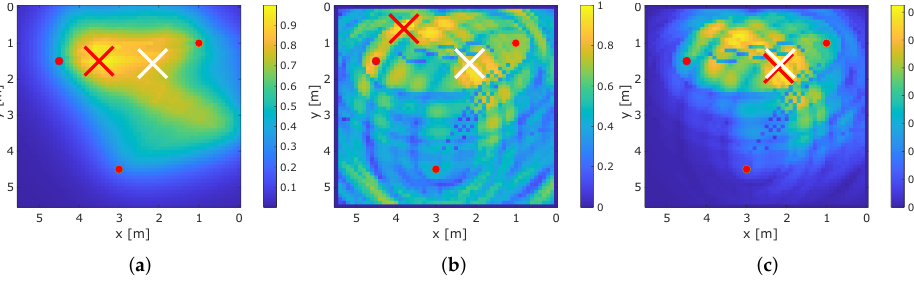
Figure 14. Heat maps for the MA-RTI, MSR and the combination at position 6. ( a ) Heat map of MA-RTI. ( b ) Heat map of MSR. ( c ) Heat map of the